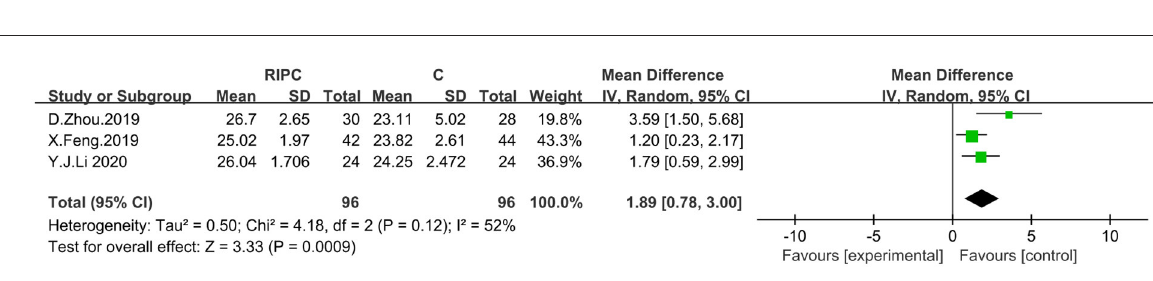
FIGURE6 Forest plot showing effect of RIPostC on MocA scores.